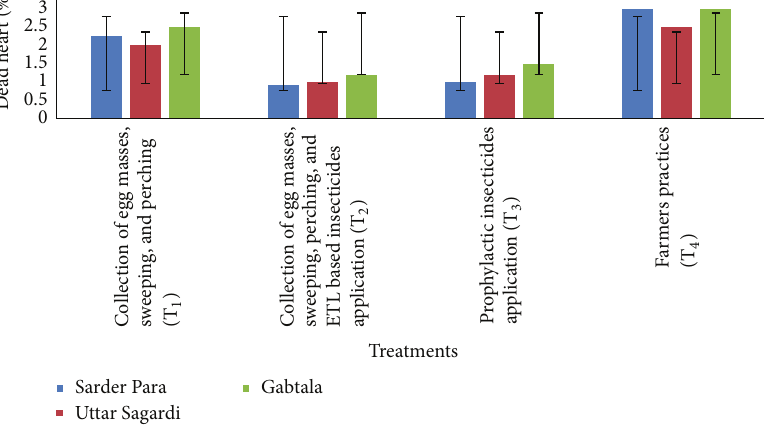
Figure 3: Percentage of dead heart by treatments.